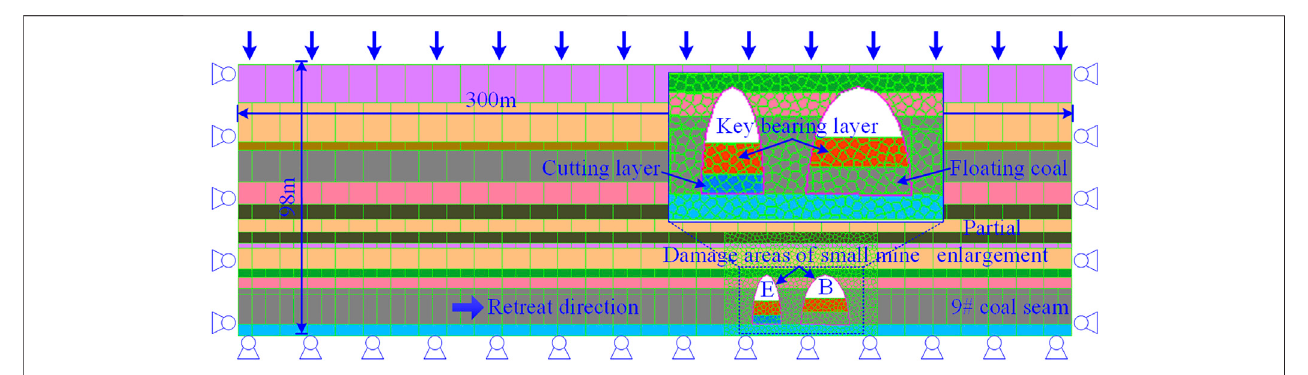
FIGURE 8 | Numerical model for analyzing rock mass behavior in response to